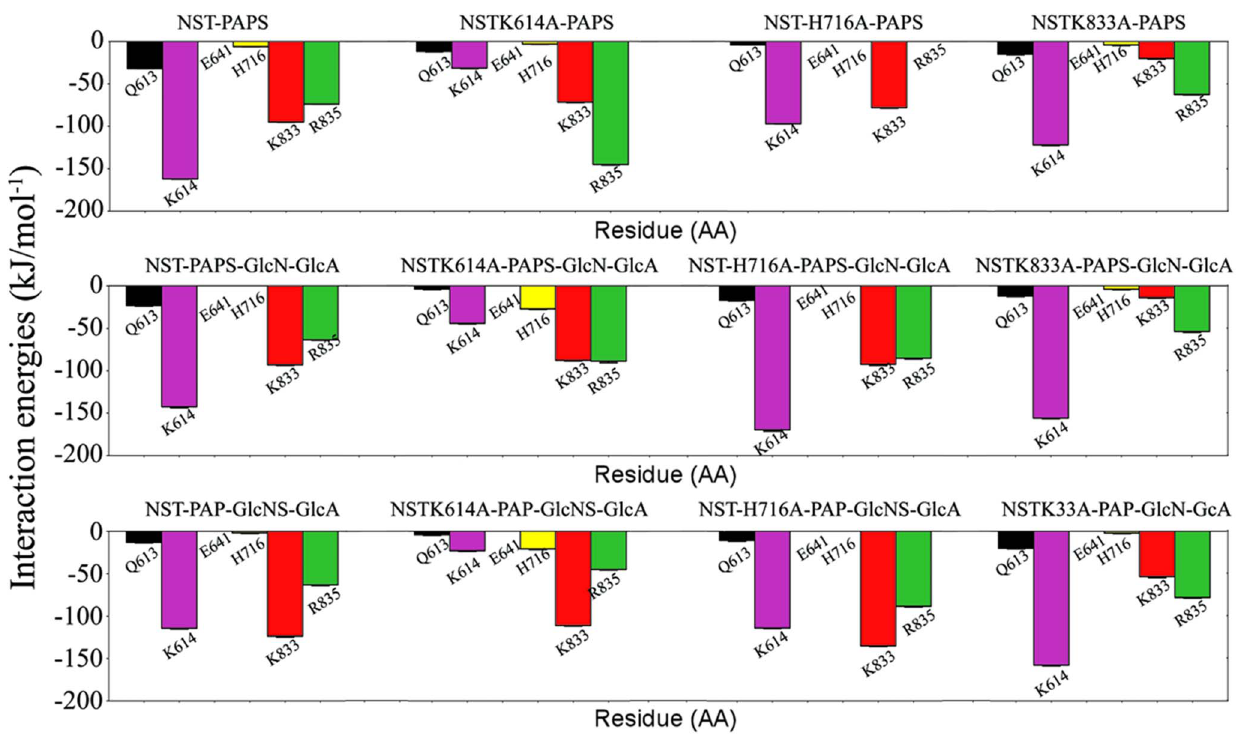
Figure 4. Per residue interaction energies between NST sidechain residues and sulfate in both PAPS and disaccharide models.